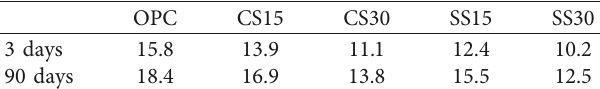
Figure 5: The TG curves of the hydration products of OPC, CS15, CS30, SS15, and SS30 (a) at 3 days and (b) at 90 days. Table 2: Calculated amount of CH, in wt.%.